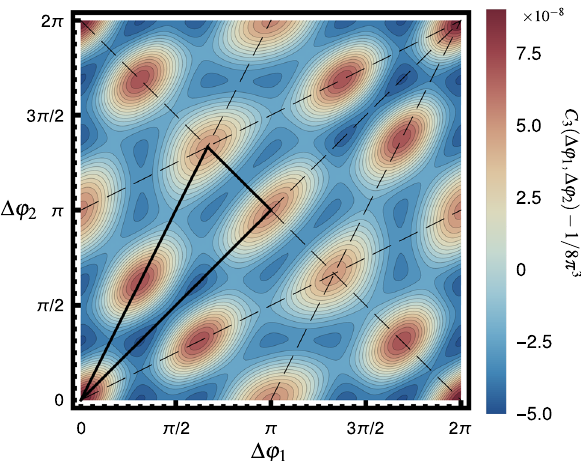
Fig. 5 Genuine three-particle correlation function, 3PC. The correla- tion is obtained from the T R ENTo + VISH2+1 + UrQMD simulation for √ s NN = 2 . 76 TeV in the 10–20% centrality class Pb–Pb collision at suring Δϕ for many events. 11 Let us call two distinguished particles in a given event as α and β with azimuthal angles ϕ α and ϕ β . Choosing all pairs of distinguished particles in an event and call them as particle 1 and 2, the particle α is labeled as particle 1 and β as particle 2 once and the par- ticle α as particle 2 and β as particle 1 again. The former labeling leads to Δϕ = ϕ 2 − ϕ 1 = ϕ β − ϕ α and the latter to − ϕ = ϕ α − ϕ β = − Δϕ . As a result, in the signal Δϕ (cid:10) = ϕ 2 1 distribution both Δϕ and − Δϕ have contribution from a sin- gle configuration of particles α and β . This labeling brings us to the following symmetry, C 2 (Δϕ) = C 2 ( − Δϕ) . One notes that the mentioned “double counting” is also considered in c n { 2 } = (cid:4)(cid:4) 2 (cid:5) − n , n (cid:5) (see Eq. (22)). As a result, this symmetry is manifestly true in Eq. (61). We also have an obvious peri- odic symmetry C 2 (Δϕ) = C 2 (Δϕ + 2 n π) for any integer n . Using these two symmetries, we find that we have indepen- dent information in C 2 (Δϕ) in the range 0 < Δϕ < π . The correlation C 2 (Δϕ) (or C 2 (Δϕ, Δη) ) is mostly reported in (cid:2) Δϕ (cid:2) 3 π to see a clear ridge and shoul- the range − π 2 2 der structures (see for instance [78]). Due to the symmetries explained above, both ridge and shoulder structures are sym- metric with respect to the axes pass through their peaks at Δϕ = 0 and Δϕ = π and only half of these structures con- < Δϕ < 3 π tain independent information in the range − π 2 2